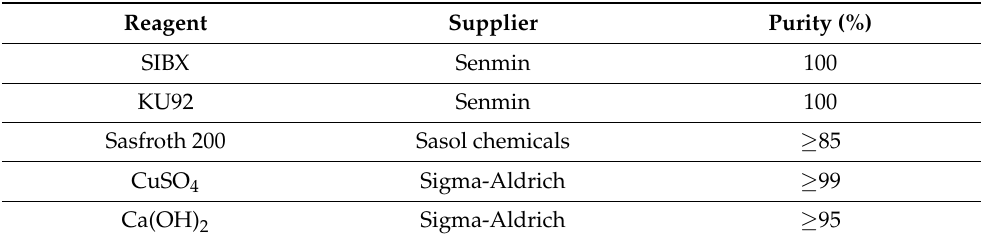
Table 1. Reagents used in this